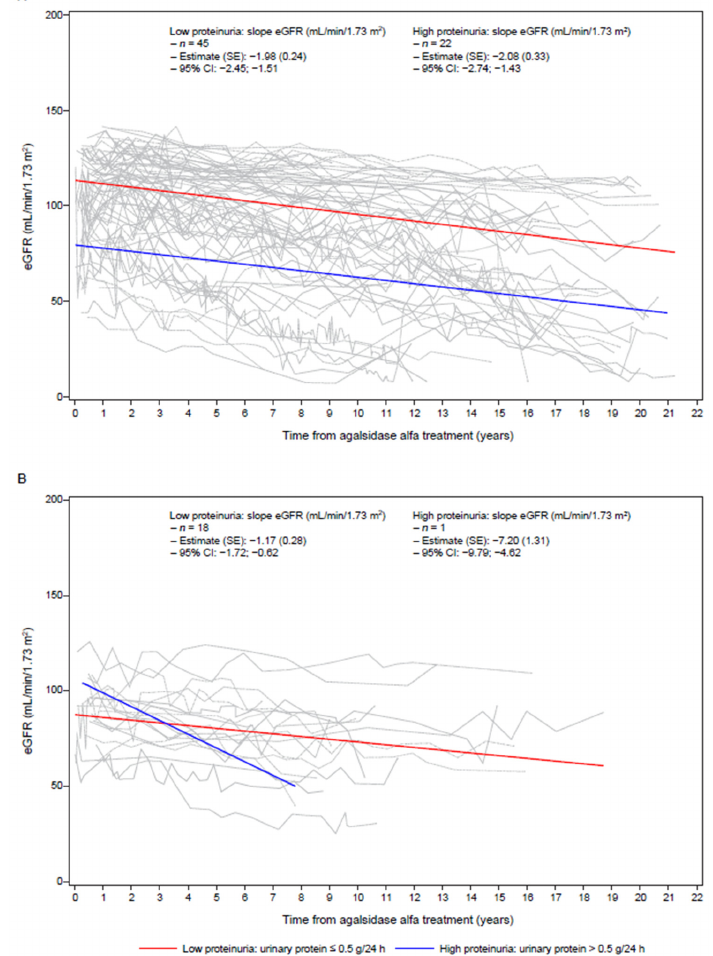
Figure 2. Change in eGFR over time by mutation subgroup and level of proteinuria at baseline. ( A ) Classic mutations. ( B ) Non-classic mutations. eGFR was measured using the CKD-EPI equation. CI—confidence internal; CKD-EPI—Chronic Kidney Disease Epidemiology Collaboration; eGFR— estimated glomerular filtration rate; SE—standard error.